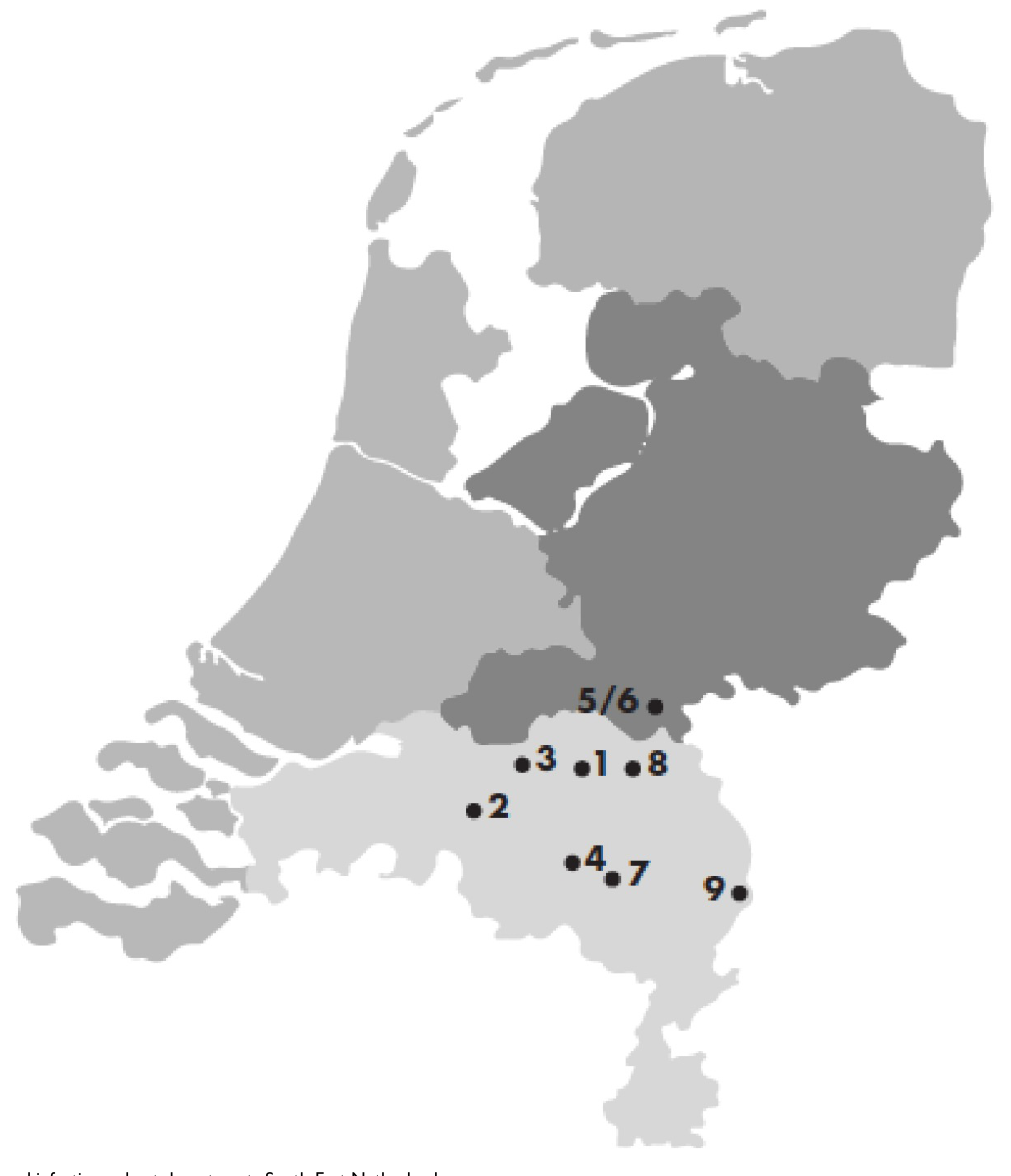
Figure 1. Regional infection cohort departments South-East